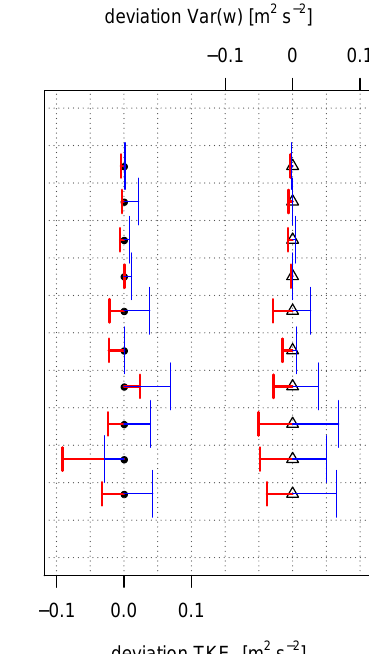
Figure 10. Height profiles of the COMPLEX flight with the altitude AMSL of the potential temperature ( left ), horizontal windspeed v h and wind direction φ , calculated with the calibration polynomial at v c 2 ( middle ). Deviations ( right ), when applying the calibration polynomials at v c 1 and v c 3 .